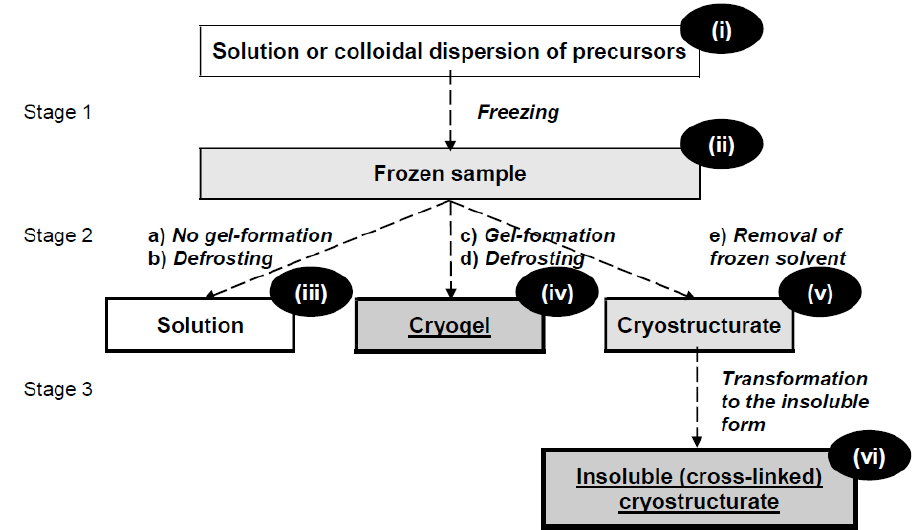
Figure 1. Principal scheme of the freezing-induced gel-formation and cryostructuring of solutions or colloidal dispersions of the respective precursors.